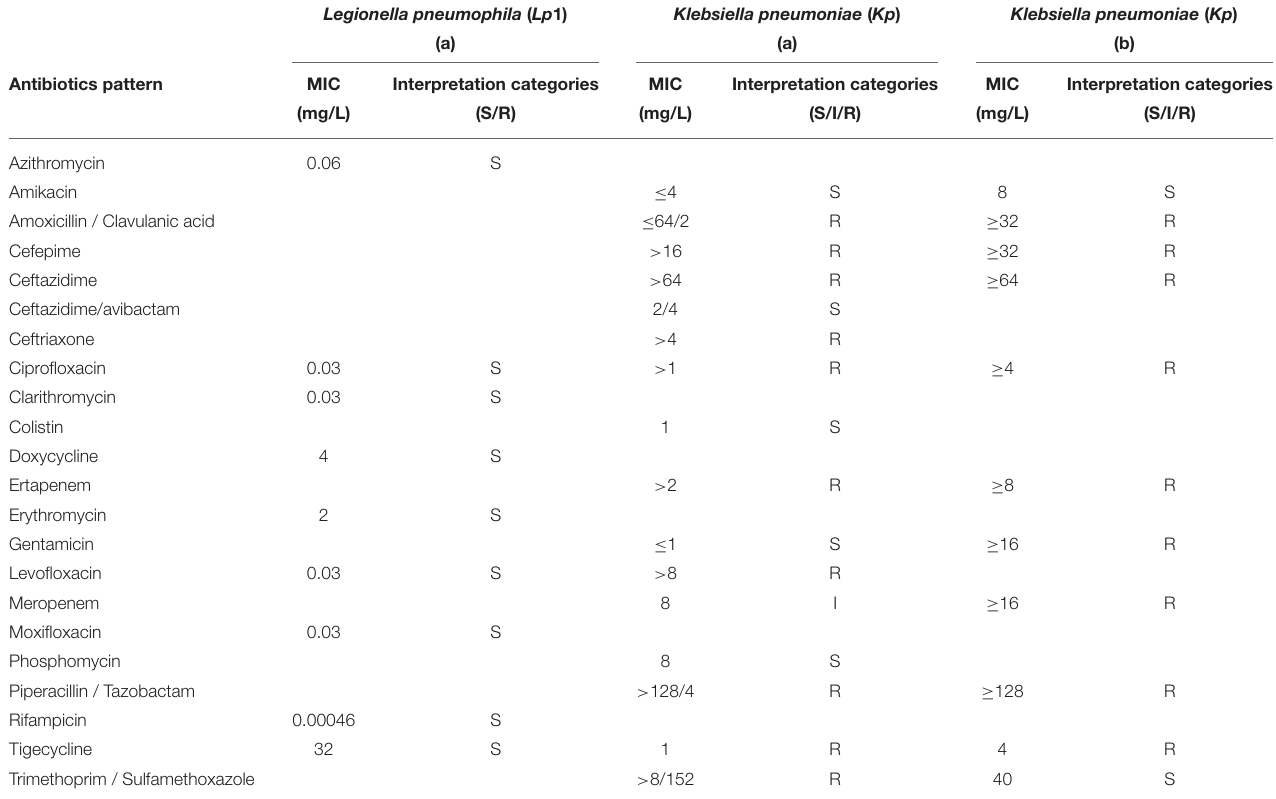
TABLE 1 | Legionella pneumophila serogroup 1 ( Lp 1) and Klebsiella pneumoniae ( Kp ) antibiotic susceptibility from (a) lung tissue fragments and (b) rectal swab